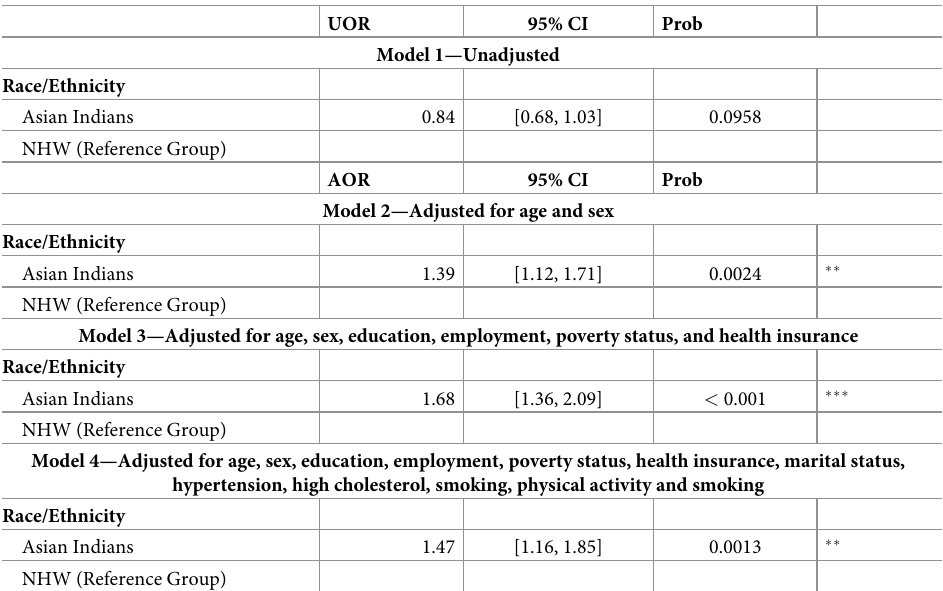
Table 2. Associations of adult Asian Indian ethnicity with diagnosed diabetes mellitus (n = 111,058), National Health Interview Survey, 2012–2016 a